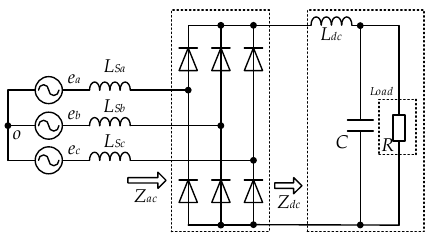
Figure 3. Impedance diagram of a three-phase full-bridge rectifier circuit.